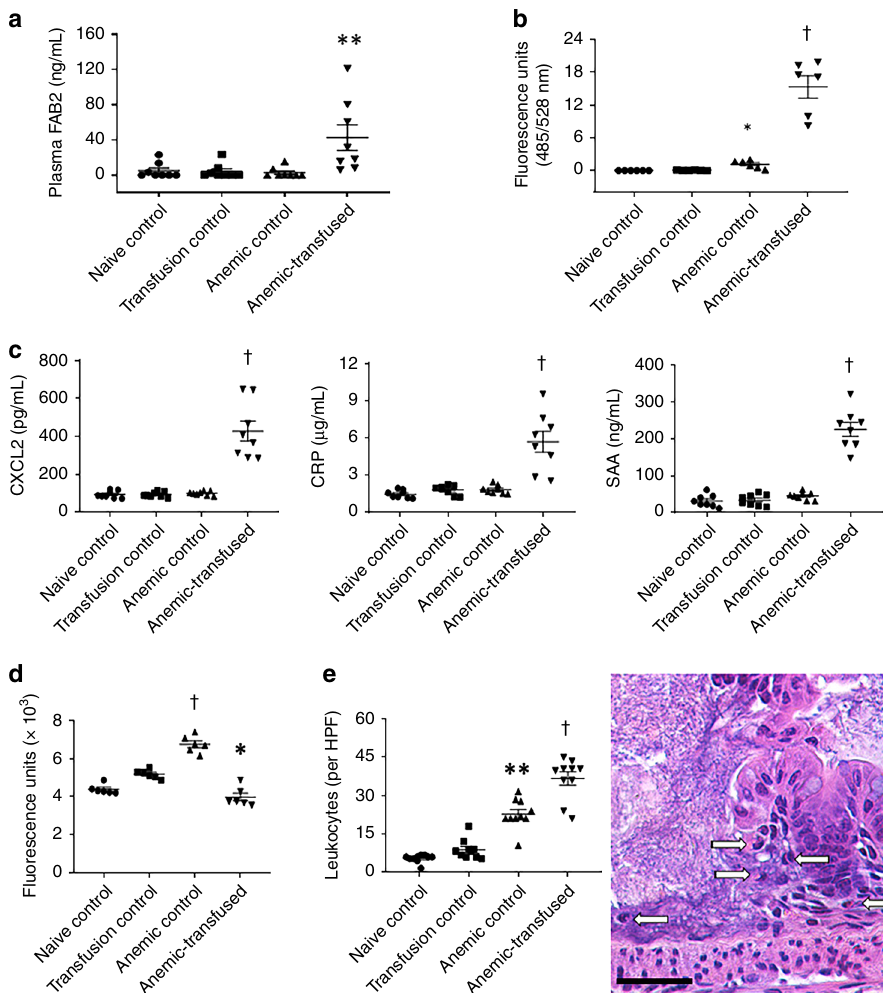
Fig. 3 In fl ammation in the anemic and anemic-transfused intestine. a Scatter column plots summarize plasma fatty acid-binding protein 2 (FABP2) concentrations. N = 8 mice per group. b Scatter plots show fl uorescence readings in plasma 4 h after gavage with fl uorescein isothiocyanate (FITC)- dextran. N = 6 mice per group. c Scatter plots show plasma CXC-motif ligand 2 (CXCL2), C-reactive protein, and serum amyloid A, measured by enzyme- linked immunosorbent assay (ELISA). N = 8 mice per group. d Seeding density of fl uorescence-labeled polystyrene microspheres in ileocecal tissue. Scatter plots show fl uorescence readings in tissue lysates, which provide an indirect estimate of regional blood fl ow. N = 6 mice per group. e Cellular in fl ammatory response in ileum and colon with necrotizing enterocolitis (NEC)-like injury. Scatter plots show number of leukocytes per high-magni fi cation fi eld. N = 10 mice per group. Right: Photomicrograph (hematoxylin – eosin, magni fi cation ×250) of anemic-transfused colon shows numerous macrophages (arrows) at the edge of an ulcer. Scale bar = 100 µ m. Data represent N = 10 anemic-transfused mice. Groups analyzed by Kruskal – Wallis H test with Dunn ’ s post